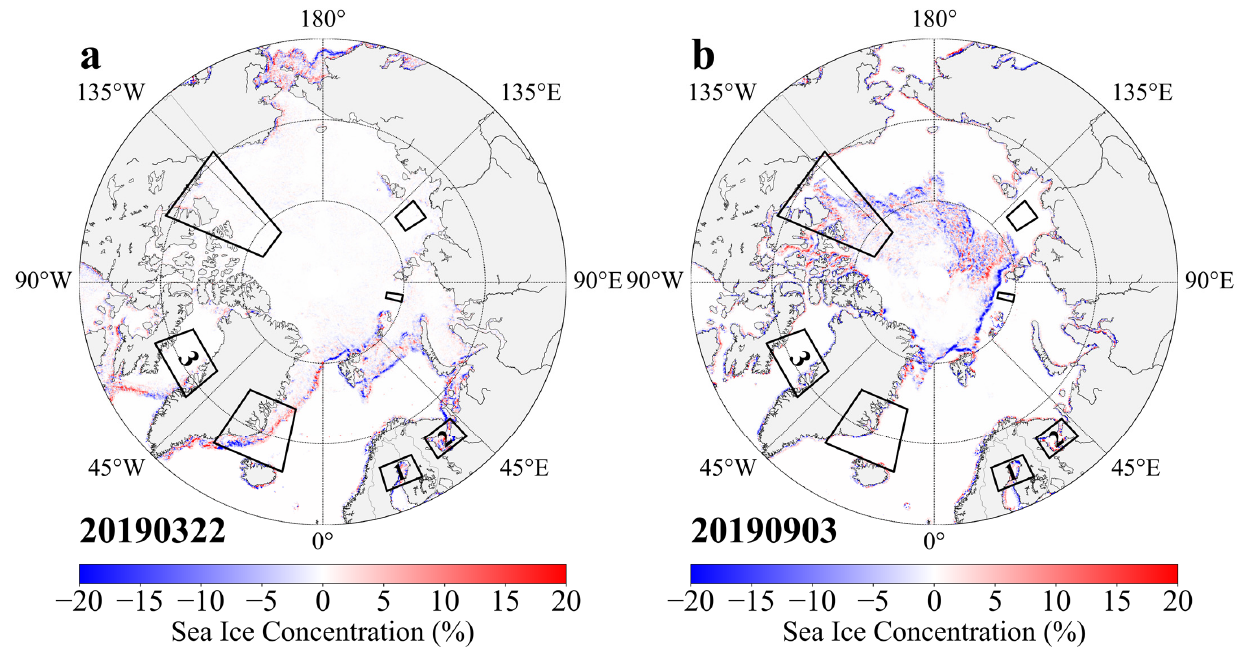
Figure 9. SIC differences retrieved by the uncorrected and corrected MWRI images in 22 March ( a ) and 3 September 2019 ( b ). The black boxes are the sample regions with cloud free MODIS images. Table 4. Comparisons of the SICs from the uncorrected and corrected images. MAE and R are mean absolute error and correlation coefficient,